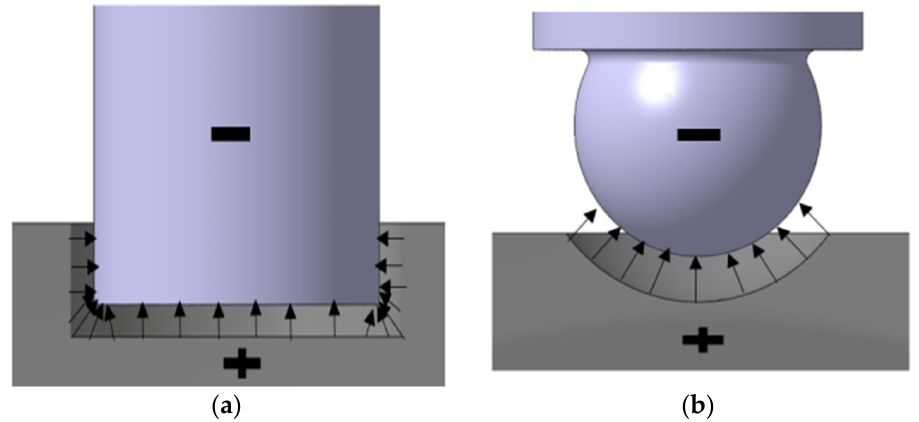
Figure 3. Tool design based on the distribution of electricity flux of the ( a ) cylinder tooltip and ( b ) spherical